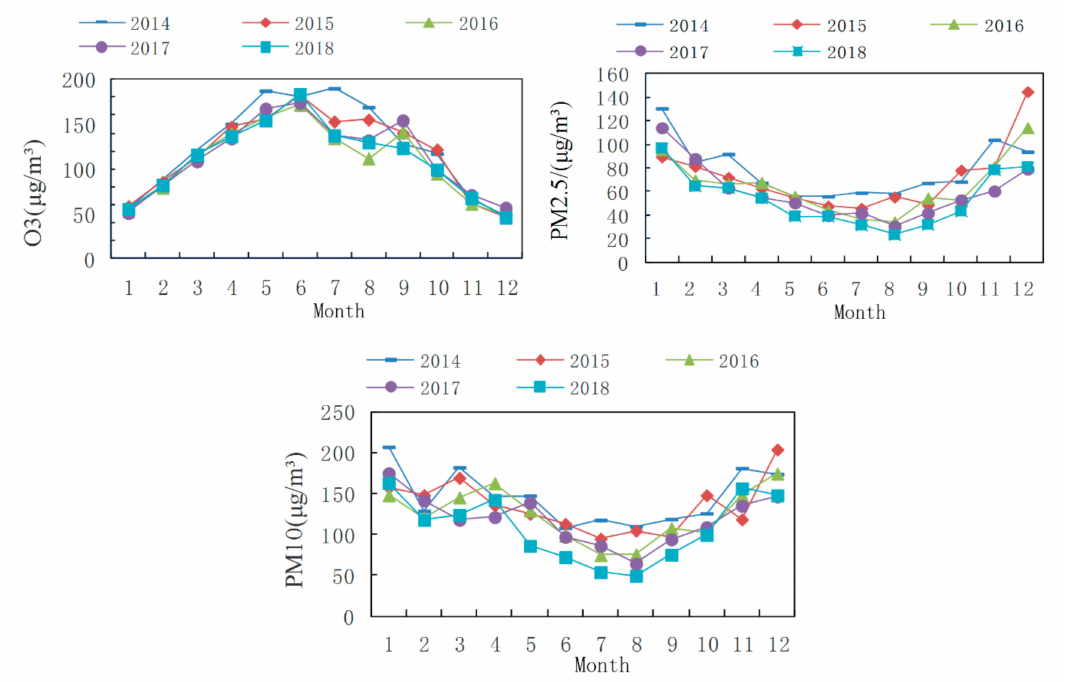
Figure 8. Monthly characteristics of the primary pollutants from